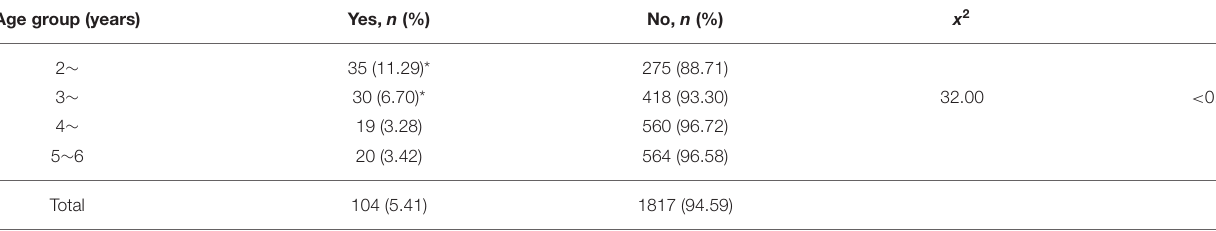
TABLE 2 | Supplementation of vitamin A in children of different age groups ( n = 1,291). Age group (years)